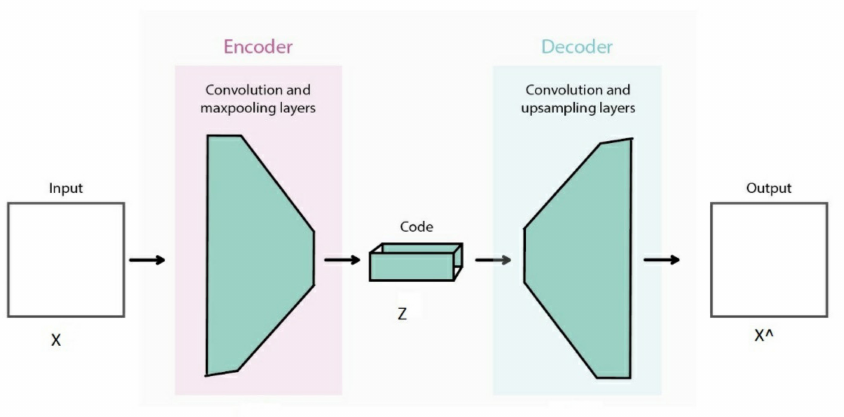
Figure 8. Autoencoder